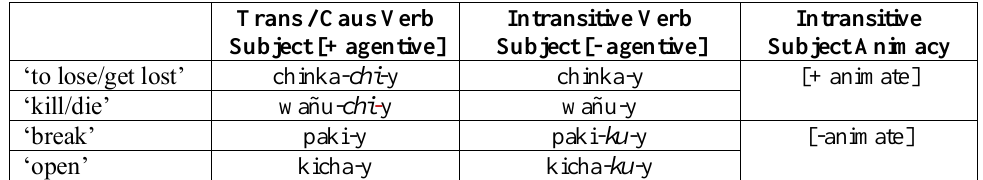
Table 10. Quechua verb: valency and subject animacy Trans / Caus Verb Subject [+